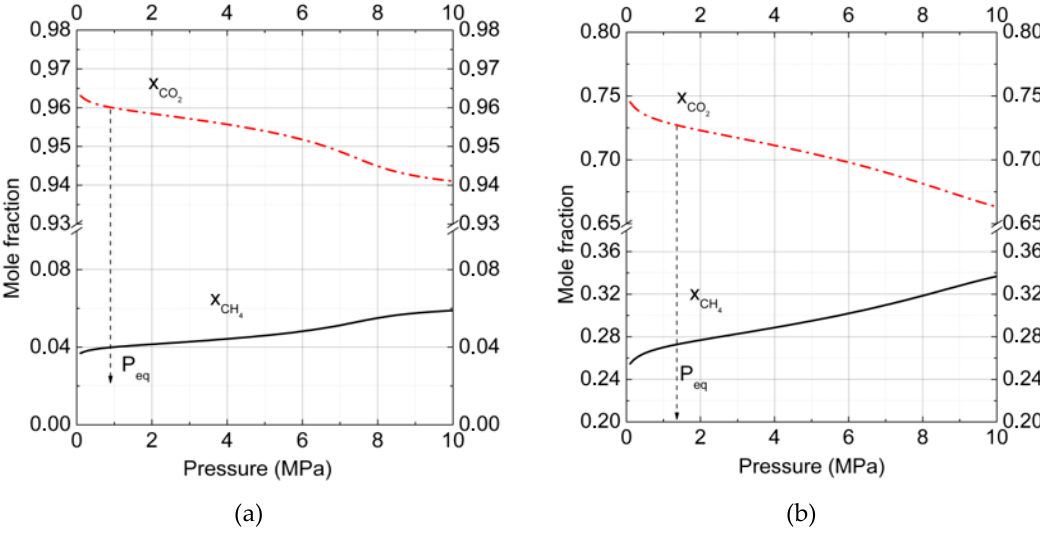
Figure 2. Mole fraction of carbon dioxide and methane in binary hydrates at T = 273 K. The gas phase consisted of ( a ) carbon dioxide (90%) and methane (10%) and ( b ) carbon dioxide (50%) and methane (50%) ( x CH = solid and x CO = dash-dotted lines). The total number of calculated points was equal to 100 with a pressure step of 0.1 MPa for each curve.